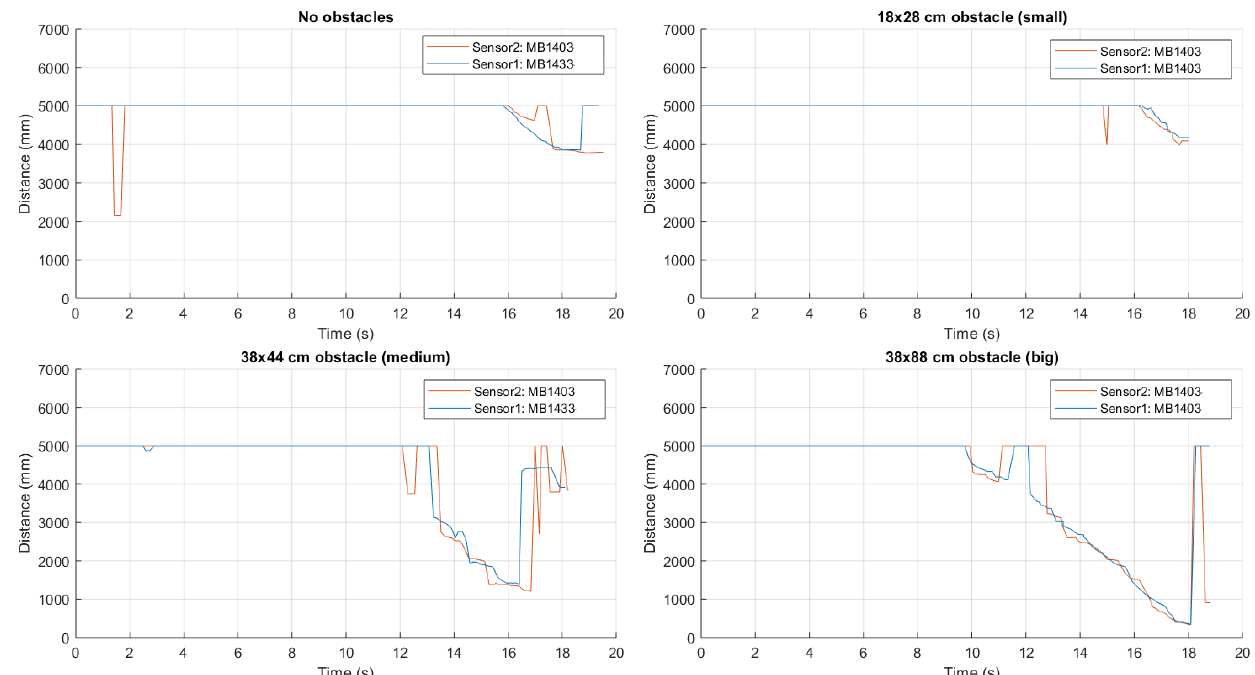
Figure 14. Distance estimates obtained with two adjacent ultrasonic sensors pointing forward.